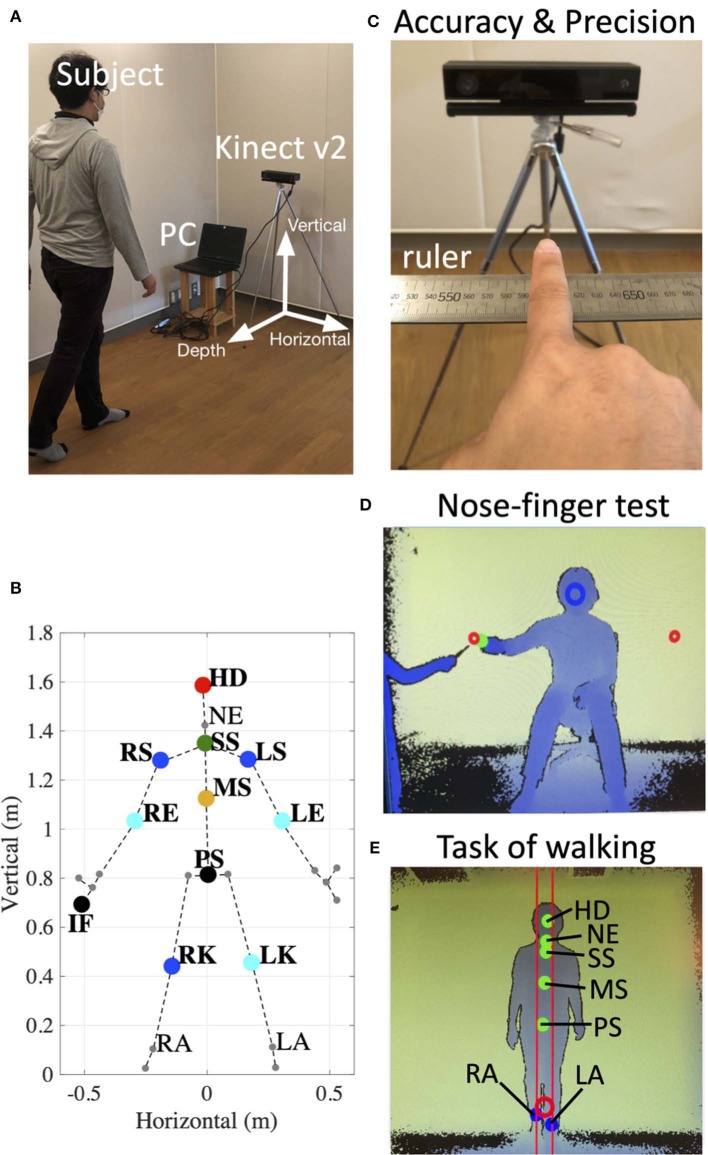
Experimental setup. (A) Arrangement of the device. Informed consent was obtained from the individual for the publication of this image. (B) 25 reference points (large dots and small dots) detected by the Kinect v2. In the present study, we focus on the markers of the right index finger (IF), right shoulder (RS), left shoulder (LS), right elbow (RE), left elbow (LE), right knee (RK), left knee (LK), head (HD), middle point of RS and LS on the spine (SS), pelvis on the spine (PS), a middle point of SS and PS (MS), neck (NE), right ankle (RA), and left ankle (LA). (C) The setup to evaluate accuracy and precision of the Kinect v2. The position of subject's IF on the ruler was compared with values obtained from the device. (D) An image obtained from depth data in the nose-finger test. The green dot indicates the position of subject's IF. The red circles show target positions. The subject was instructed to keep his/her nose within the blue circle. (E) An image obtained from depth data in the task of walking. The dots show the positions of HD, NE, SS, MS, and PS, RA, and LA. The subject was instructed to hold a center position of his/her RA and LA within the red circle.